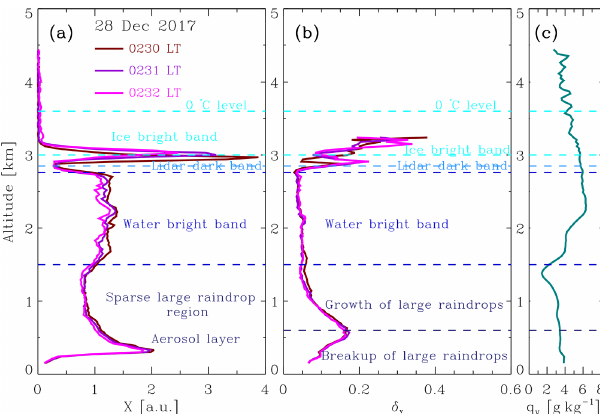
Figure 4. Lidar profiles for weak precipitation that reached the sur- face (drizzle). (a) Range-corrected 355nm signal X profiles from 01:12 to 01:14LT on 28 December 2017; (b) 355nm volume depo- larization ratio δ v profiles in the same period and (c) 1h averaged lidar q v profile centered at 01:13LT on the same day.